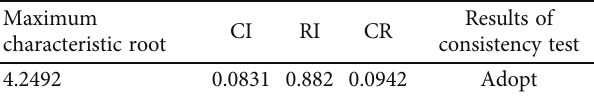
Table 4: Results of consistency